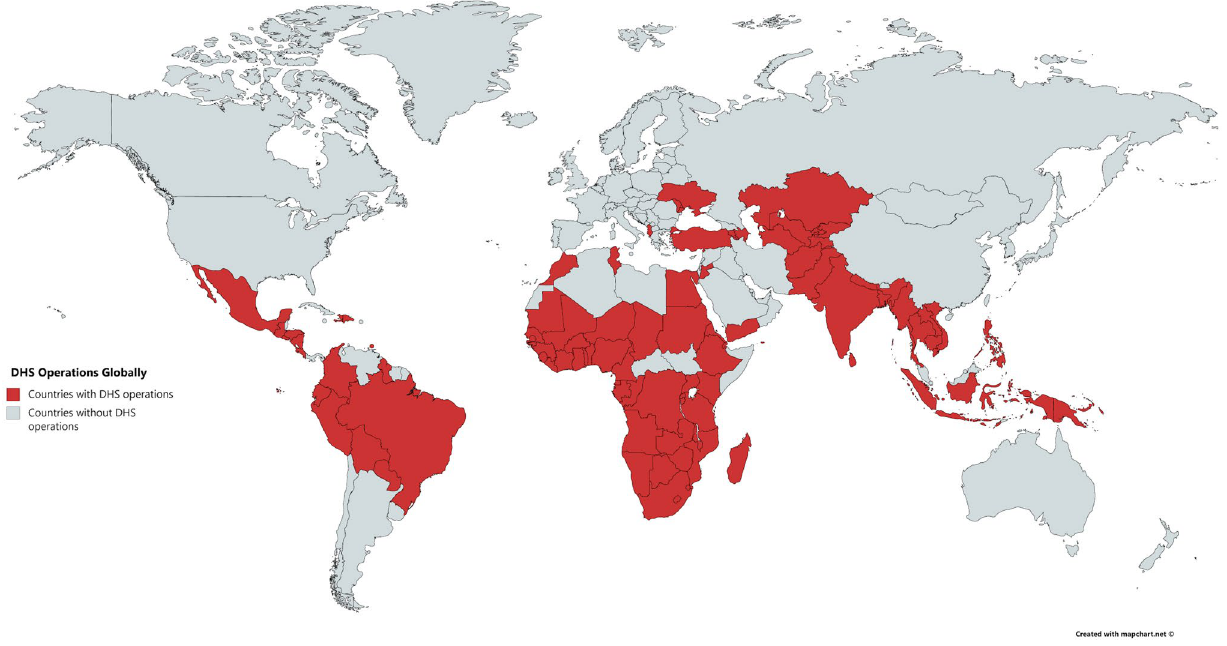
Figure 1. DHS operations globally. Source: https:// dhspr ogram. com/ Count ries/ index. cfm? show= count ries; map created at www. mapch art.